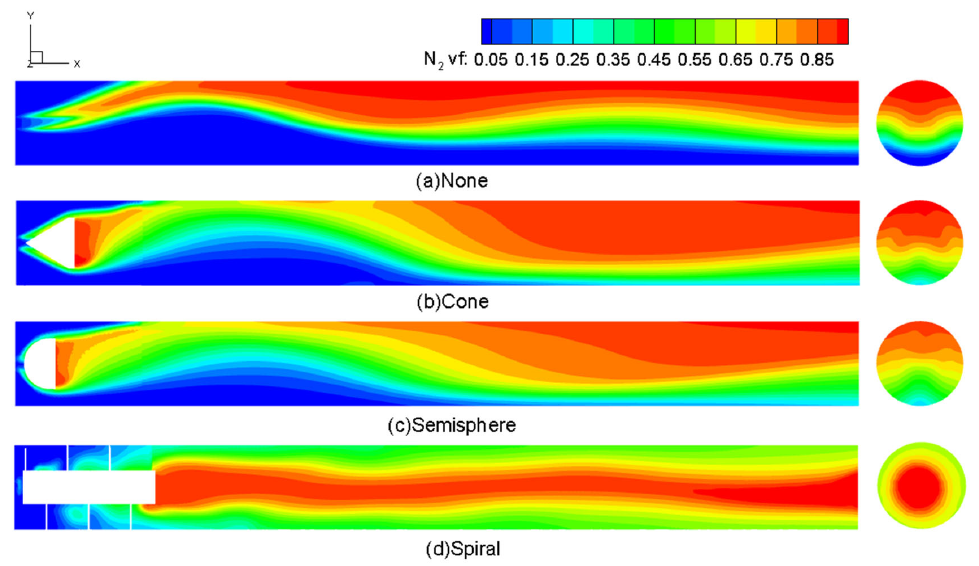
Figure 8. The nitrogen volume fraction distributions of four shaped spoilers at z = 0 mm and outlets ( a – d ).